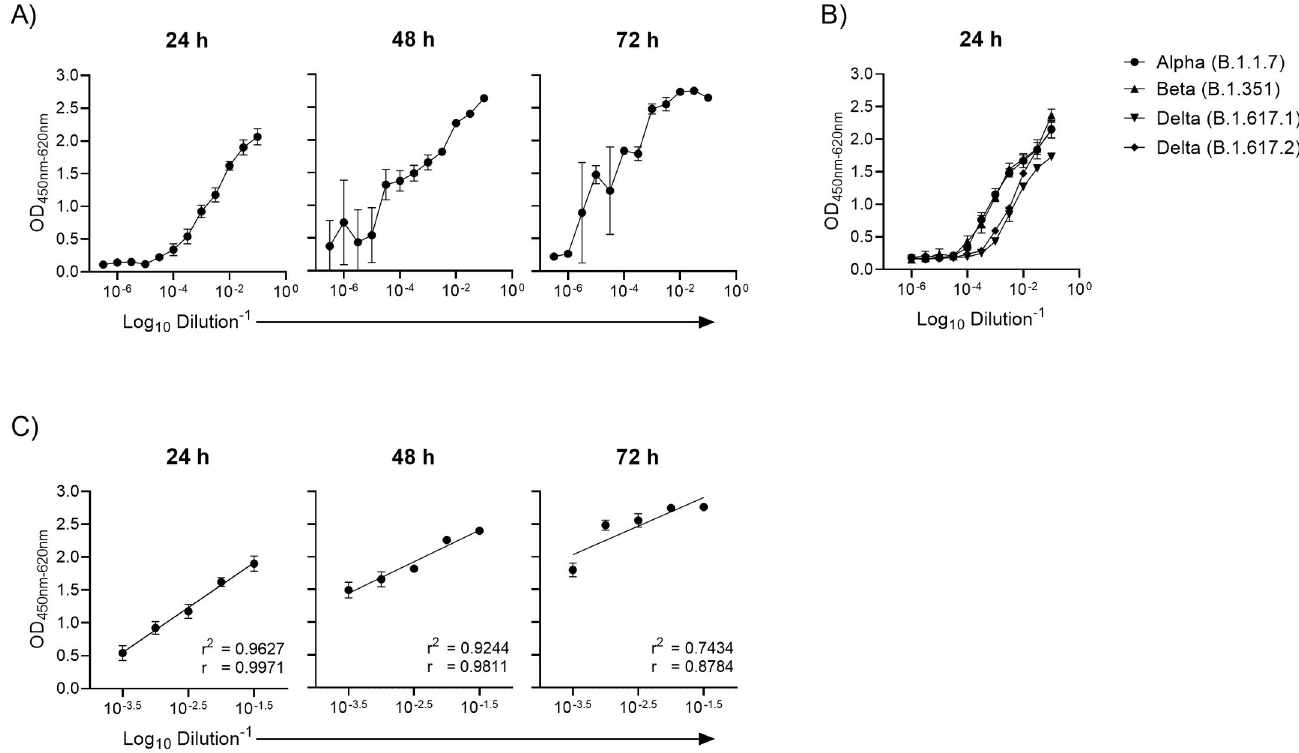
Fig 1. Relationship between virus inoculum size and SARS-CoV-2 nucleocapsid protein measured at 24, 48 and 72 hours post-inoculation. (A) A serial dilution of SARS-CoV-2 early pandemic strain (lineage B.1) was transferred from a master stock to three identical cell culture plates seeded with 10 4 Vero E6 cells per well the preceding day. An anti-SARS-CoV-2 nucleocapsid ELISA was performed on washed and fixed cells after 24, 48 and 72 hours. Each data point represents the mean of quadruplicate measurements with the standard deviation. ELISA primary antibody: rabbit mAb 40143-R019. (B) Different SARS-CoV-2 variants of concern treated as described in (A) show a similar linear relationship between inoculum and nucleocapsid protein levels measured by ELISA 24 hours post-inoculation. The comparison between strains was done on the same day using a single dilution for each serum sample. ELISA primary antibody: mouse mAb BSM-41414M. (C) Linear regression and Pearson correlation test of virus inoculum size and SARS-CoV-2 nucleocapsid protein level in the quantification range from a dilution of 10 − 3.5 to 10 − 1.5 . r 2 = Goodness of fit. r = Pearson correlation coefficient. Error bars represent standard deviations of replicate determinations.